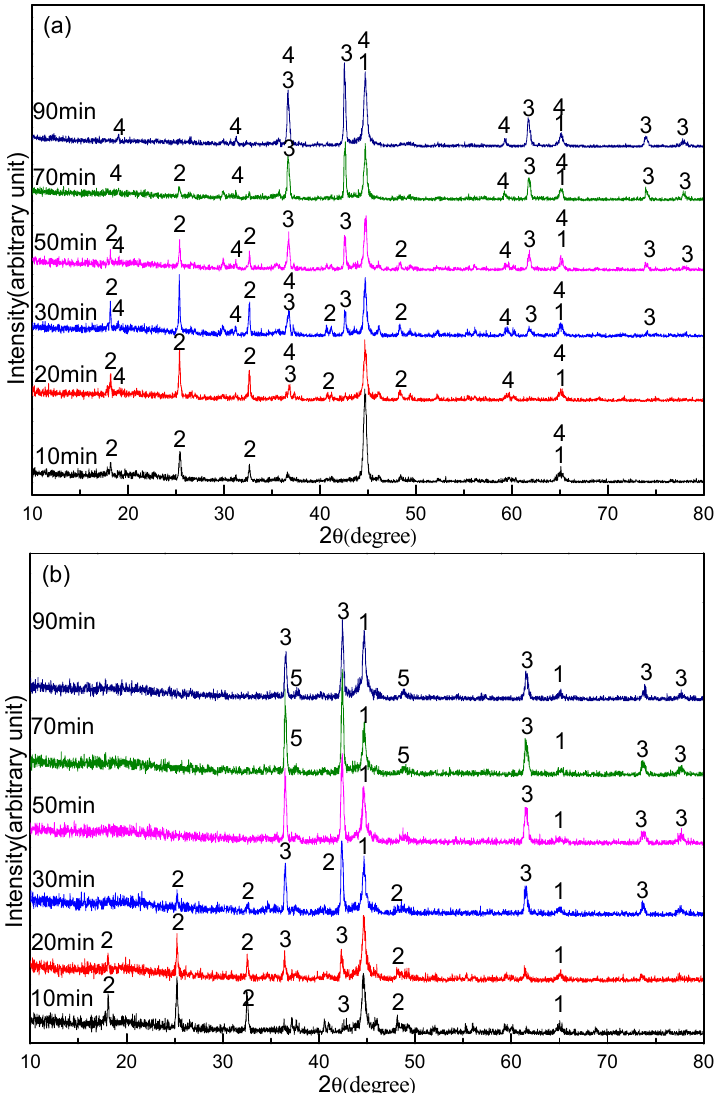
Figure 5. XRD patterns of the pellets reduced at 1300 °C for different time: ( a ) without additive and Figure5. XRDpatternsofthepelletsreducedat1300 ◦ Cfordifferenttime: ( a )withoutadditiveand( b )with ( b ) with 16% sodium borate . 1—Fe(PDF#06 ‐ 0696); 2—M 3 O 5 (Fe 2 TiO 5 , PDF#41 ‐ 1432; Mg 2 TiO 5 , PDF#35 ‐ 16% sodium borate. 1—Fe(PDF#06-0696); 2—M 3 O 5 (Fe 2 TiO 5 , PDF#41-1432; Mg 2 TiO 5 , PDF#35-0796; 0796; Ti 3 O 5 , PDF#09 ‐ 0309); 3—TiN(PDF#38 ‐ 1420); 4—MgAl 2 O 4 (PDF#21 ‐ 1153); 5—Fe 3 C(PDF#76 ‐ 1877). Ti 3 O 5 , PDF#09-0309); 3—TiN(PDF#38-1420); 4—MgAl 2 O 4 (PDF#21-1153); 5—Fe 3